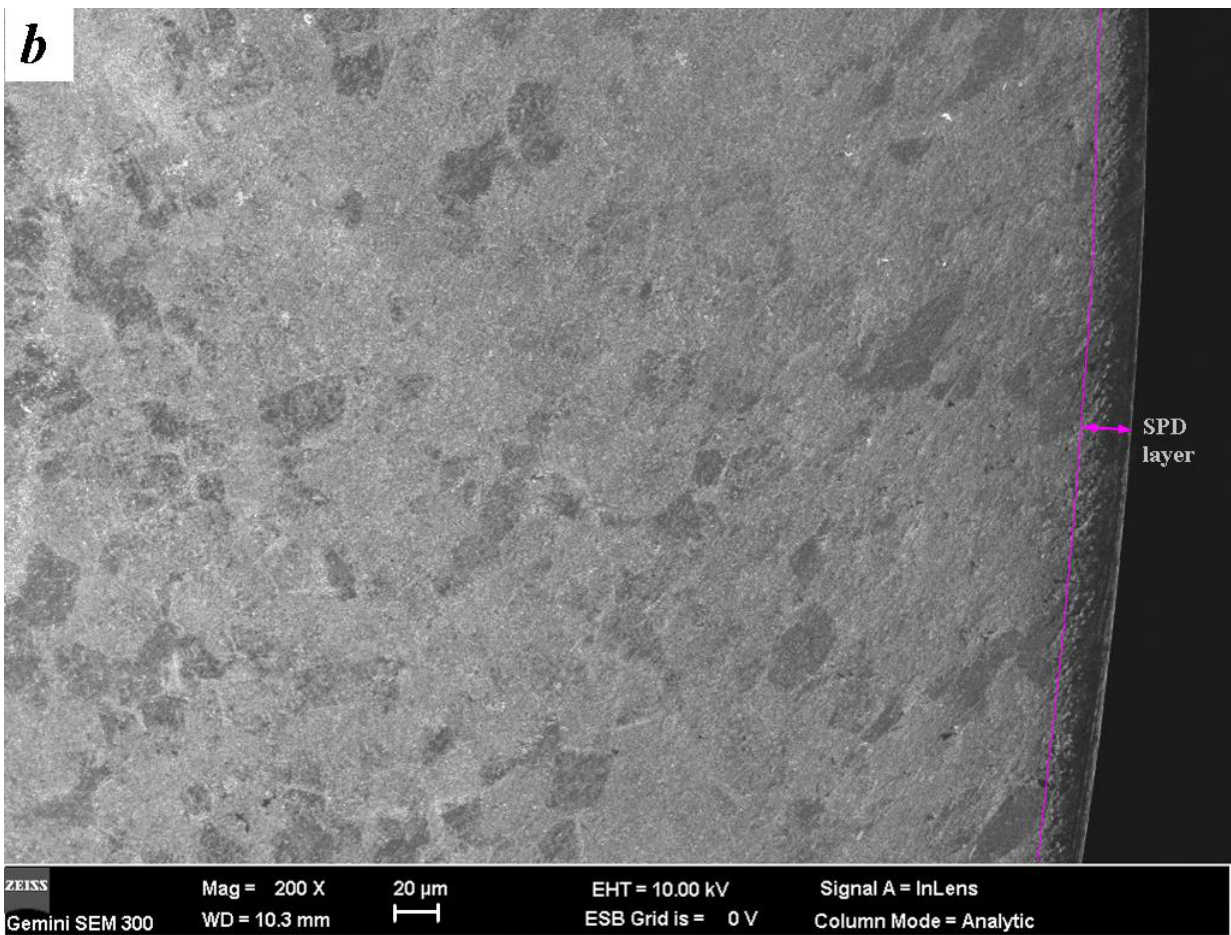
Figure 2. SEM images of metallographic observation: ( a ) Ti6Al4V; ( b ) Ti3Zr2Sn3Mo25Nb. α -phase of titanium has a high stacking fault energy of more than 300 mJ/m 2 , β -phase with body centered cubic has 12 slip directions. Crystal–plane slip easily happens in most titanium alloys under the action of cyclic loads. Thus, the mechanism of forming nanograins in titanium alloy is mainly dislocation motion. Twinning is investigated in α -titanium sporadically [15]. TEM observations of the SPD layers induced by ultrasonic surface impact are shown in Figure 3. High density dislocations and dislocation cells are obviously investigated after the treatment of ultrasonic surface impact. The selected area electron diffraction (SAED) pattern of the area with a depth of 3 µ m in the SPD layer is nearly concentric annulus. To both the two titanium alloys, there are thin dislocation walls. nanometer scales. The lattice constants of SPD layers calculated from Figure 3d are much less than those which are given in reference [20]. The surface grains of TLM reach nanosize, similarly. Continuous slip bands are interweaved on the β -phase crystal. In general, the severe plastic deformation has helped the surface grains to transform into